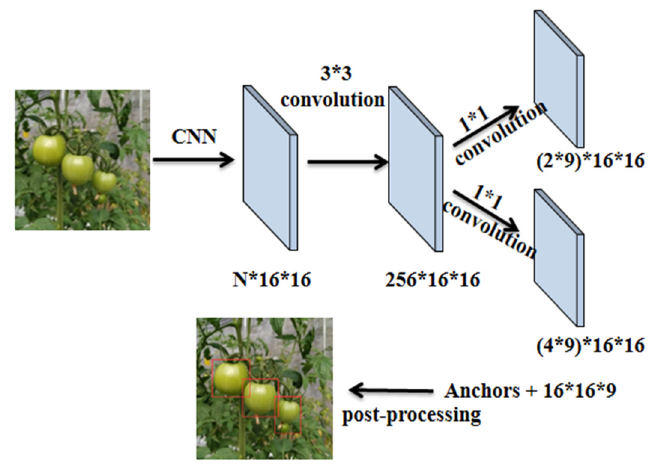
Figure 6. The process diagram of RPN.